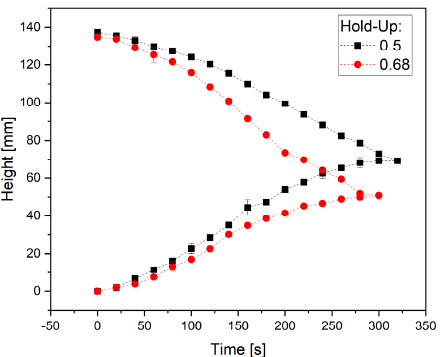
Figure 12. Settling curves of the ATPE settling test for two different hold-ups.